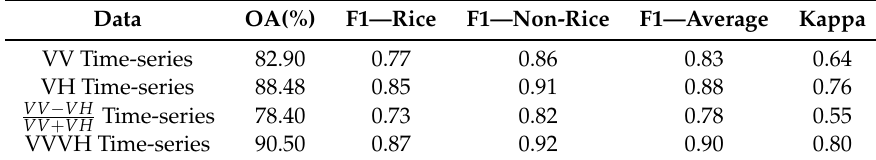
Table 4. Rice map classification evaluation over four feature datasets.